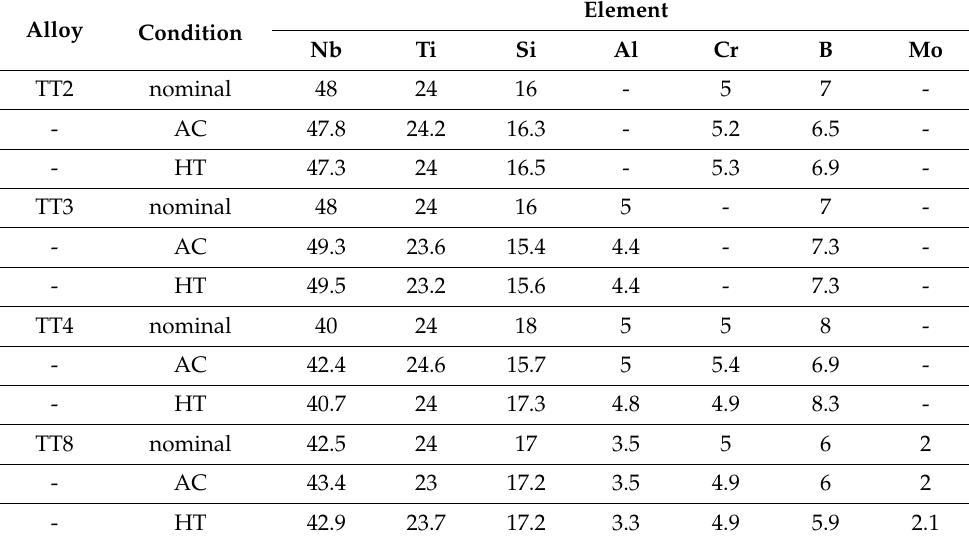
Table 1. Nominal and actual composition (at.%) of as cast (AC) and heat-treated (HT) alloys. Alloy